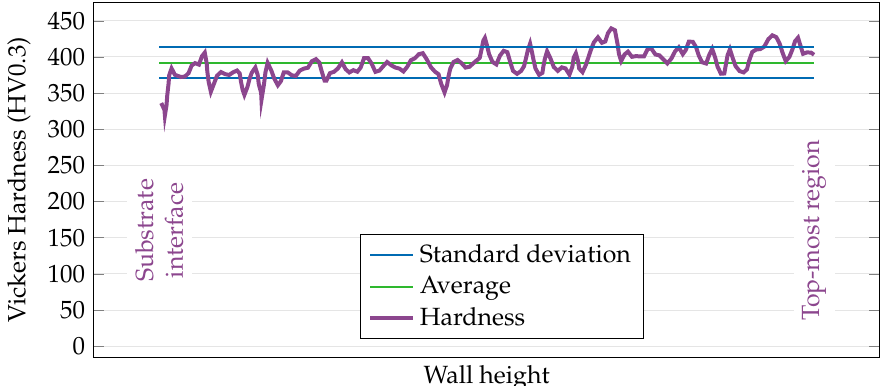
Figure 11. Microhardness graph across the printed wall from the bottom to the topmost region.